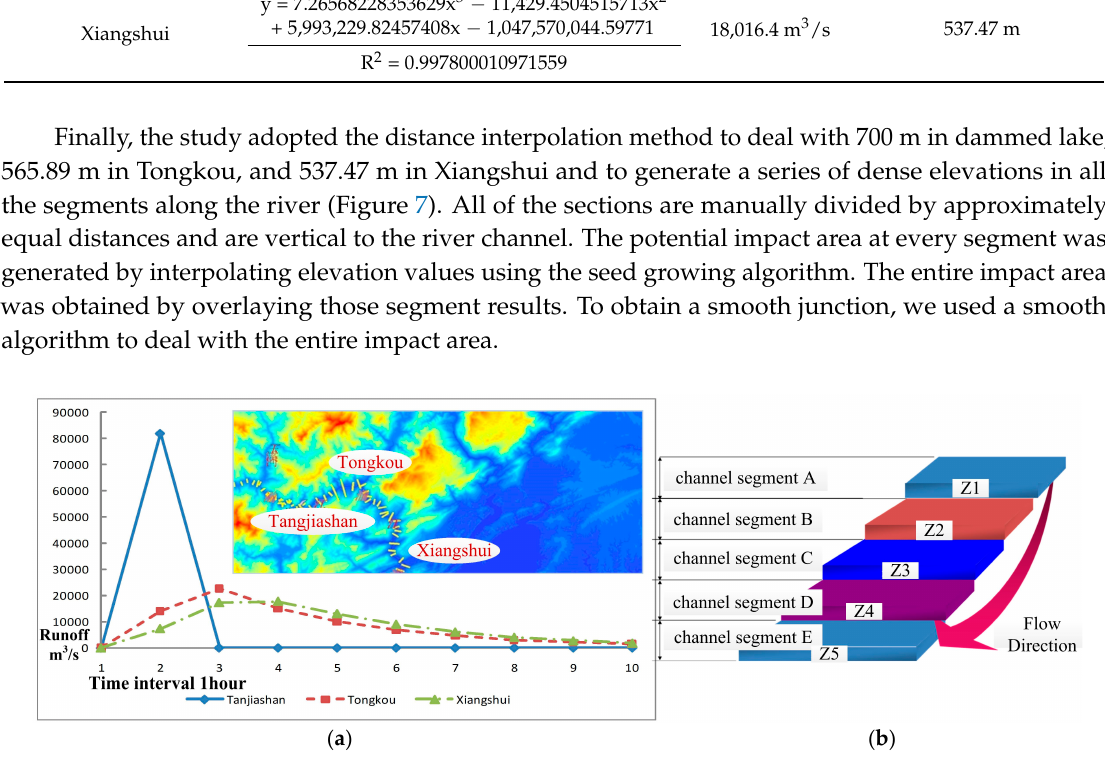
Figure 7. Muskingum flood routing results and elevation interpolation method. ( a ) Flood routing results based on Muskingum method and segments division; ( b ) The elevation interpolation along the river.